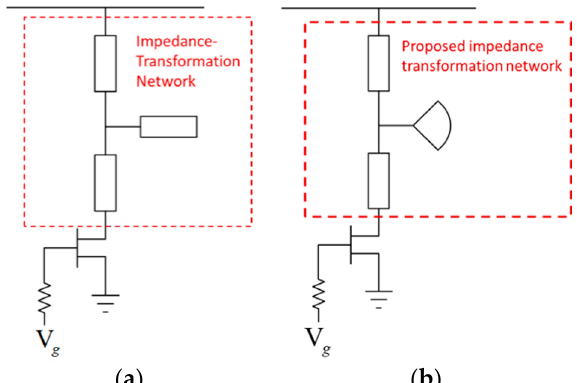
Figure 4. Topology of the impedance transformation network.: ( a ) conventional configuration with open-stub element; ( b ) proposed one with radial-stub element.